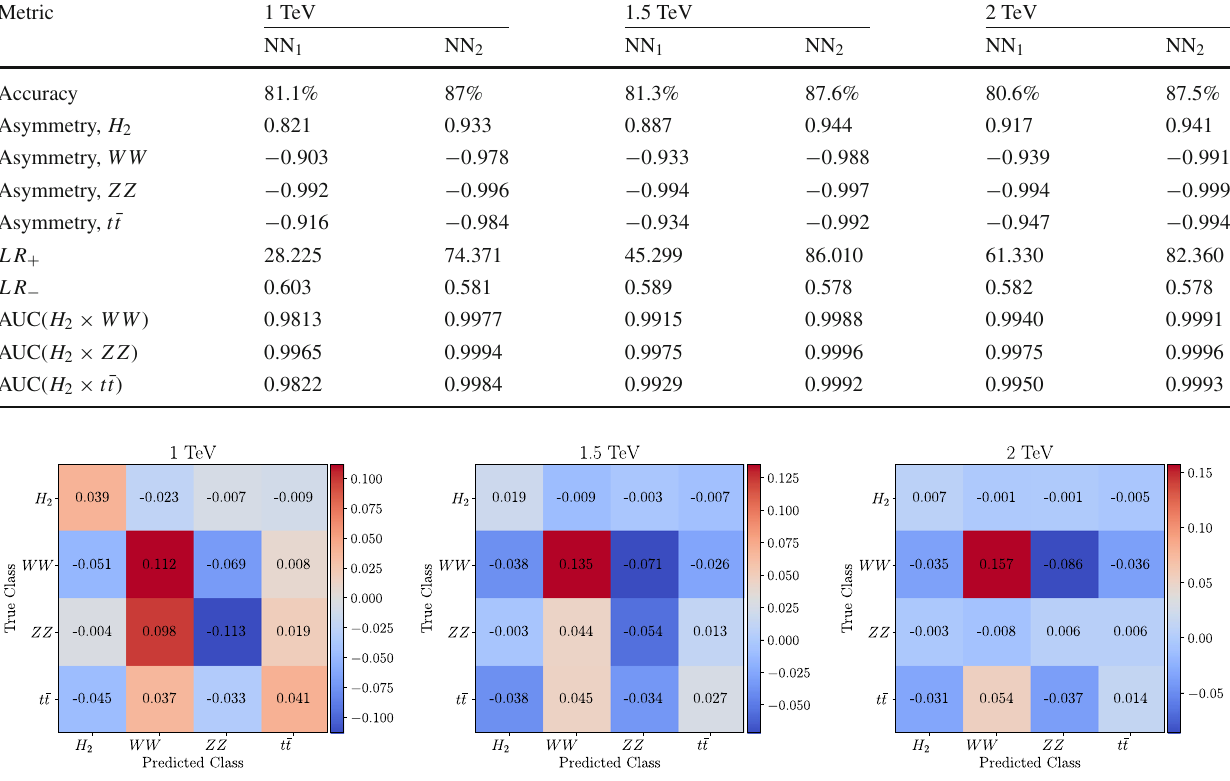
Fig. 9 Confusion matrices differences (NN 2 − NN 1 ) for models trained to separate Higgs bosons of mass 1 TeV (left), 1.5 TeV (center), and 2